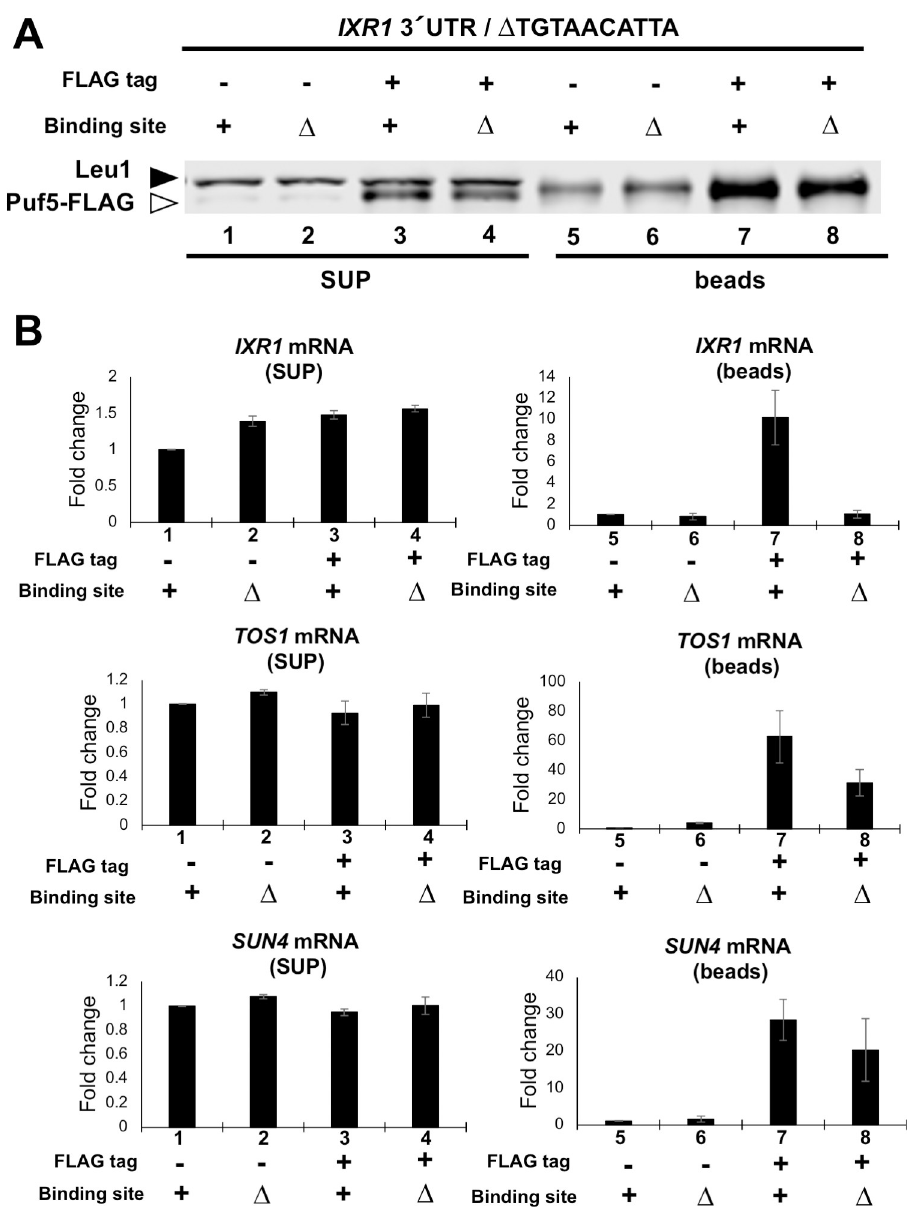
Fig 8. Puf5 binds to 3´ UTR of IXR1 mRNA. (A,B) RIP analysis data clarifying the binding between Puf5 protein and IXR1 mRNA. The extract was obtained from ixr1 Δ PUF5-FLAG-ADH1 3´ UTR strain harboring the YEplac195- IXR1 plasmid, and Puf5-FLAG protein was immunoprecipitated with anti-FLAG antibody. The ixr1 Δ untagged- PUF5 strain was used as a negative control. Sample 1–4 contain the supernatant, and sample 5–8 contain the immunoprecipitants. Sample 1 and 5, untagged strain with Puf5-binding element; sample 2 and 6, untagged strain without Puf5-binding element; sample 3 and 7, FLAG-tagged strain with Puf5-binding element; sample 4 and 8, FLAG-tagged strain without Puf5-binding element. (A) Puf5-FLAG protein level in supernatant and immunoprecipitants. The white arrowhead corresponds to Puf5-FLAG protein, and the black to Leu1 protein. (B) IXR1 mRNA levels in the supernatant and the immunoprecipitants. TOS1 mRNA levels and SUN4 mRNA levels were presented as positive controls. The mRNA levels were quantified by qRT-PCR analysis, and the fold change was calculated relative to the mRNA level in the untagged strain with Puf5-binding element (sample 1 for the supernatant, and sample 5 for the immunoprecipitants).